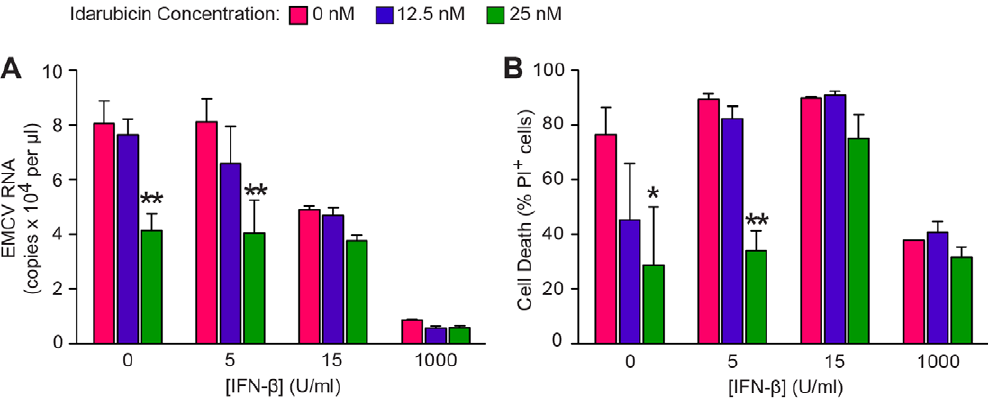
Figure 8. Idarubicin provides control of viral titer. (A) 2fTGH cells were treated with idarubicin or DMSO vehicle and with IFN- b for 6 h and then inoculated with EMCV (MOI 1) for 1 h. Viral titers in cell supernatant were measured at 28 h after inoculation using real-time quantitative PCR assay for EMCV RNA. Values represent mean 6 SE (n=3 biological replicates, n=2 technical replicates). Overall significance for idarubicin dose p , 0.0001, IFN dose p , 0.0001, and Interaction p , 0.05. (B) For the protocol used in (A), the corresponding levels of virus-induced cell toxicity based on cell viability from propidium iodide (PI) staining. Overall significance for idarubicin dose P , 0.0001, IFN dose p , 0.0001, and Interaction p=ns. The p-values for individual comparisons (vs 0 idarubicin control) are from Bonferroni post-tests from two-way ANOVA (idarubicin x IFN dose). Symbols: *p , 0.05, **p , 0.01, ***p , 0.001.